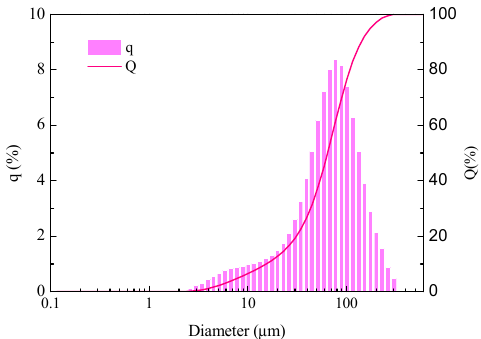
Figure 6. Particle size distribution of activate sludge in MBR.